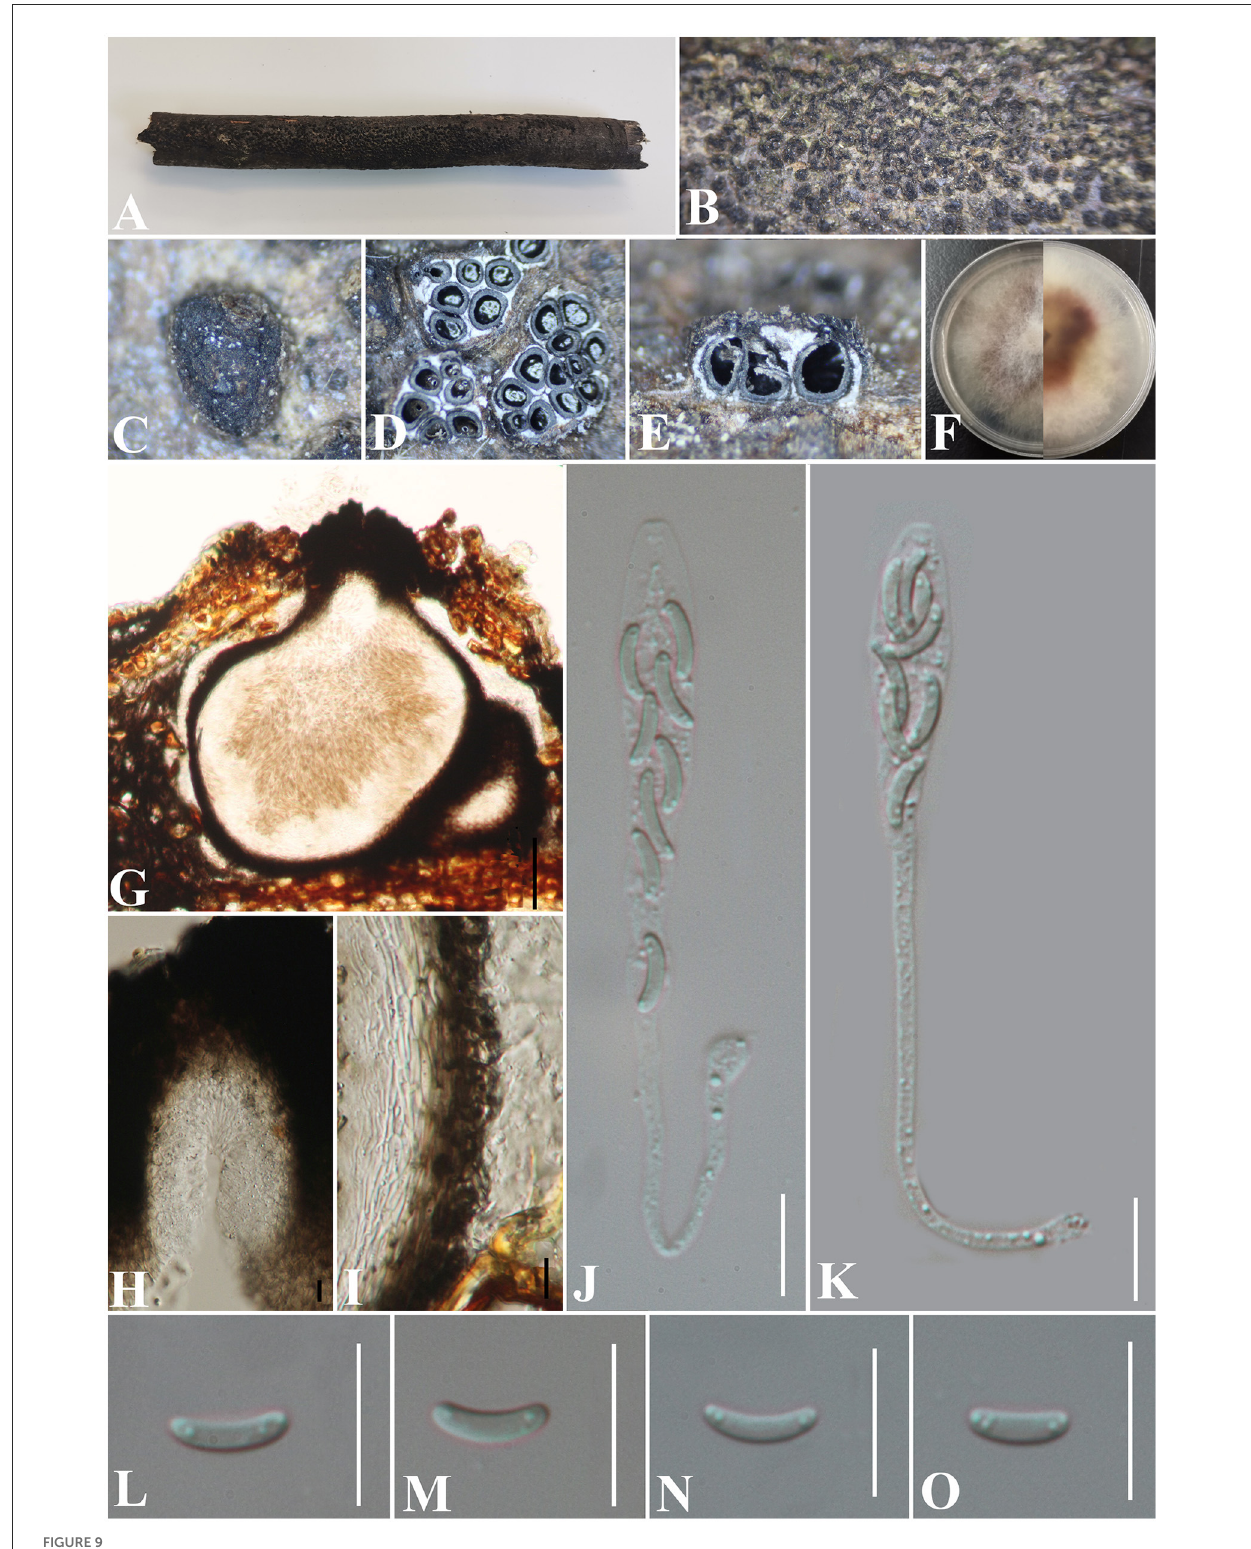
FIGURE9 Diatrypella guiyangensis (GMB0414, holotype). (A) Type material. (B, C) Close-up of stromata. (D) Transverse section through stromata. (E) Vertical section through stromata. (F) Cultures on PDA. (G) Section through the ascostroma. (H) Ostiolar canal. (I) Peridium. (J, K) Asci. (L–O) Ascospores. Scale bars: (G) = 50 µ m; (H–O) = 10 µ